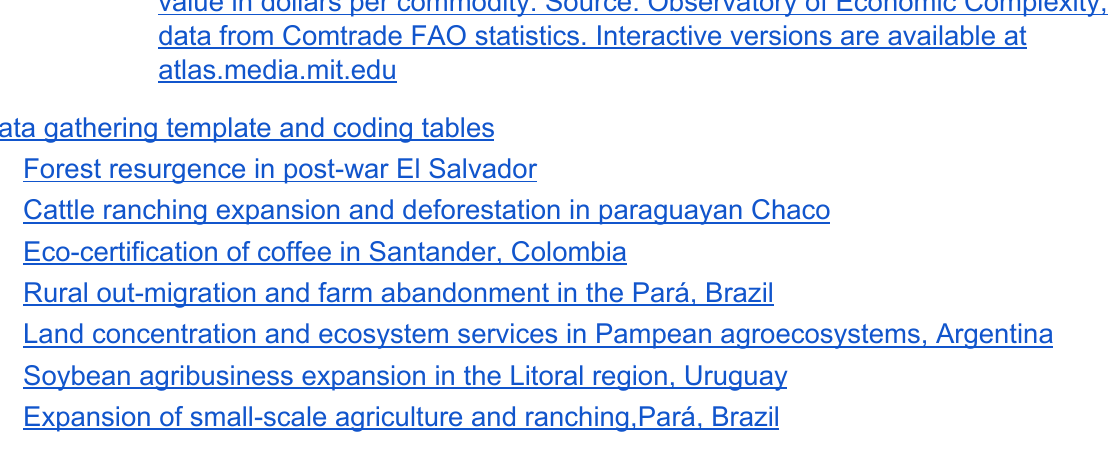
Figure A1.1. CLD Forest resurgence in post-war El Salvador Figure A1.2. CLD cattle ranching expansion and deforestation in paraguayan Chaco Figure A1.3. CLD eco-certification of coffee in Santander, Colombia Figure A1.4. CLD rural out-migration and farm abandonment in the Pará, Brazil Figure A1.5. CLD land concentration and ecosystem services in Pampean agroecosystems, Argentina Figure A1.6. CLD Soybean agribusiness expansion in the Litoral region, Uruguay. Figure A1.7. CLD expansion of small-scale agriculture and ranching,Pará, Brazil Trade Figure A1.8. Export profiles in year 2000 (left) and 2015 (right) for Uruguay (a,b), Paraguay (c,d), Argentina (e,f). Areas are proportional to the export value in dollars per commodity. Source: Observatory of Economic Complexity, data from Comtrade FAO statistics. Interactive versions are available